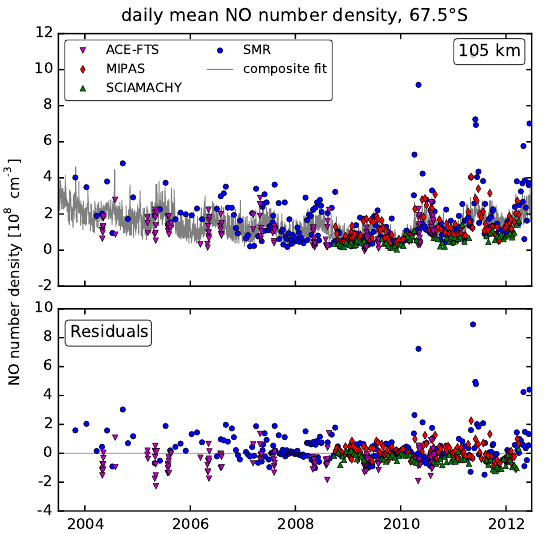
Figure 11. NO time series regression results at 67.5 ◦ N, 85km. The upper panel shows the individual time series and the composite re- gression fit using all data simultaneously. The lower panel shows the individual residuals with respect to the composite fit.